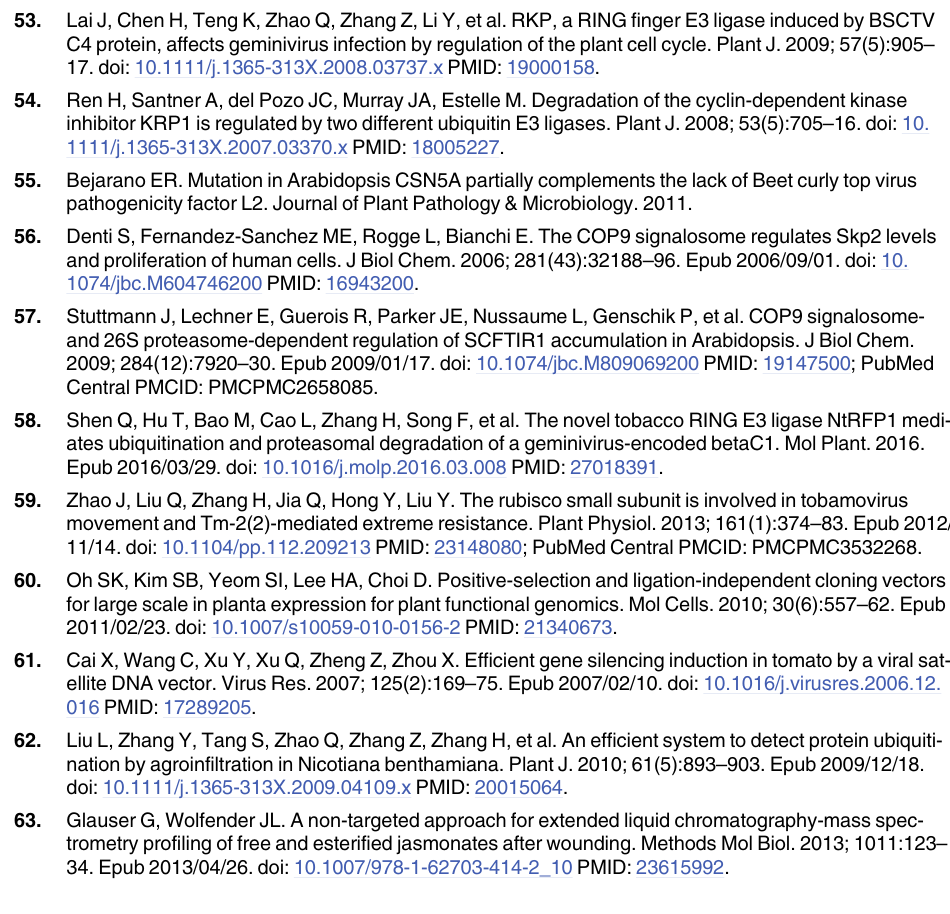
PLOS Pathogens | DOI:10.1371/journal.ppat.1005668 June 17,